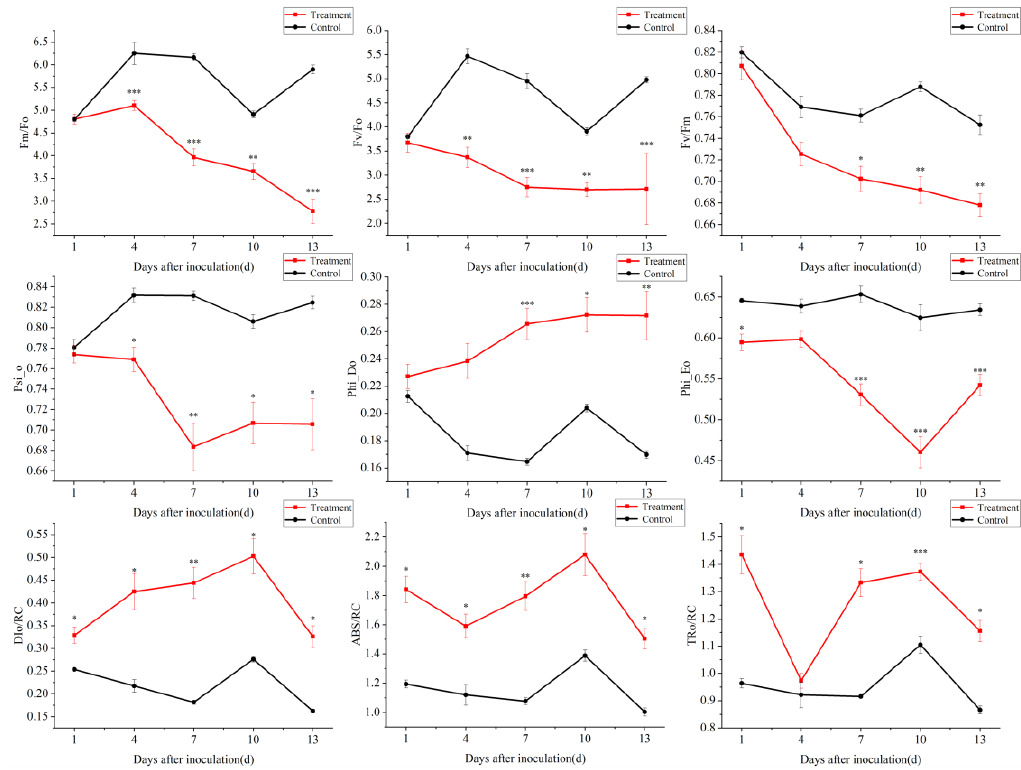
Figure 3. Analysis of chlorophyll fluorescence parameters of P. thunbergii needles under PWN stress. * p < 0.05, ** p < 0.01, *** p < 0.001 using Duncan’s multiple range test.